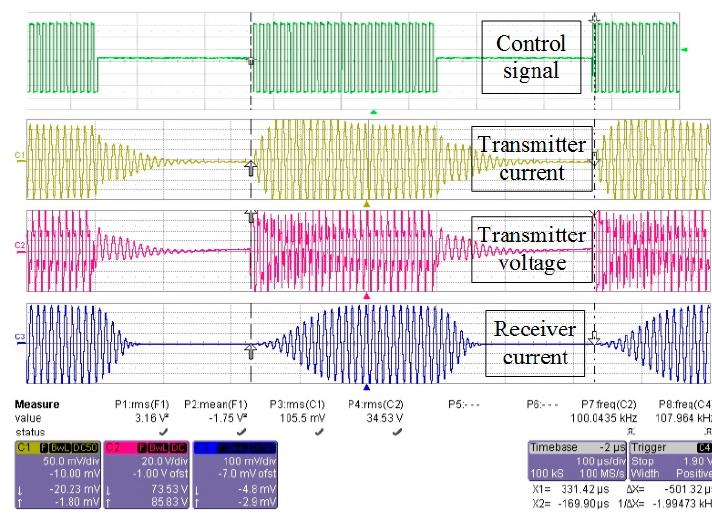
Figure 11. Waveforms of motor 2 at duty ratio of 60%.